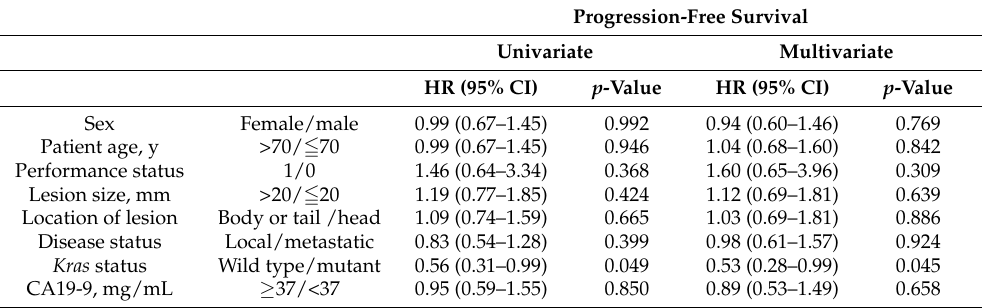
Figure 3. Overall survival according to Kras status after first–line chemotherapy with GEM and nab–PTX. The median OS in the wild-type Kras and the mutant Kras group was 19.9 and 11.8 months, respectively. OS was significantly longer in the wild-type Kras group than in the mutant Kras group ( p = 0.037). Table 4. Univariate and multivariate analyses of prognostic factors with progression-free survival.